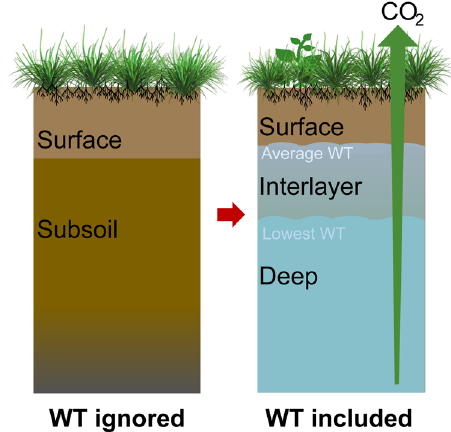
Fig. 1 Carbon release from the pro fi le of drained peatlands. Previous research focused on absolute depth, neglecting the effects of water table fl uctuations, which divided soil pro fi le into three layers: oxic surface, oxic- anoxic transitional interlayer, and anoxic deep (WT water